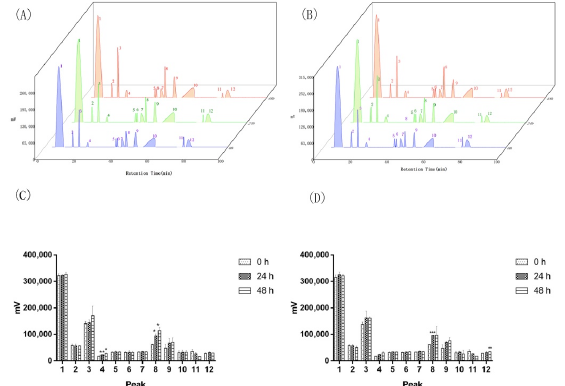
Figure A2. Illicium verum Hook. f powder fermentation ( A , C ): Bs-2 was added in Anise powder and sterilized saline, and then the suspension was thoroughly mixed and incubated. Samples were taken at 0 h, 24 h, and 48 h and filtered for HPLC analysis. ( B , D ): Bs-4 was added in Anise powder and sterilized saline, and then the suspension was thoroughly mixed and incubated. Samples were taken at 0 h, 24 h, and 48 h and filtered for HPLC analysis. * p < 0.05, ** p < 0.001, and *** p <